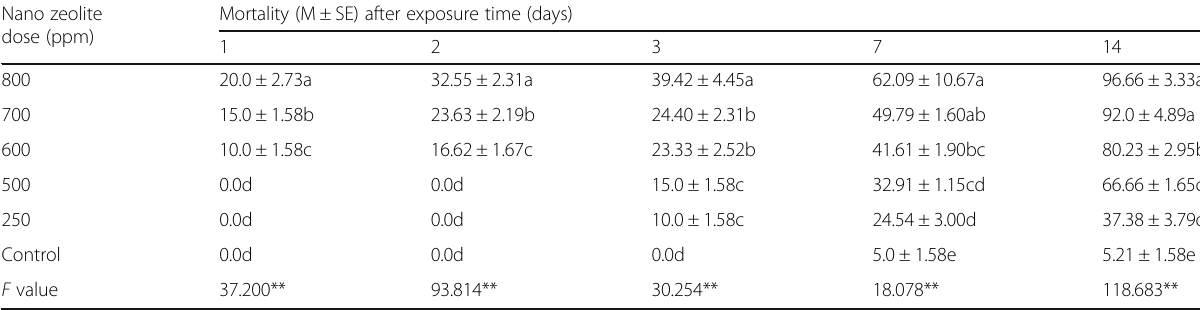
Table 2 Effect of nano zeolite (40 – 45 nm) against T. confusum adults at different dose rates